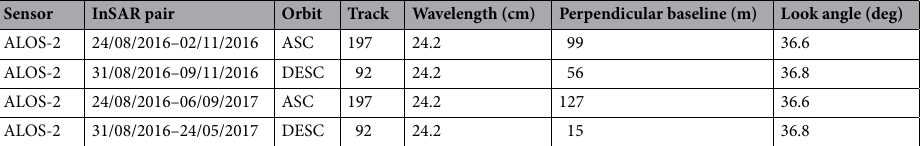
Table 1. ALOS-2 coseismic interferometric pairs exploited for the DInSAR